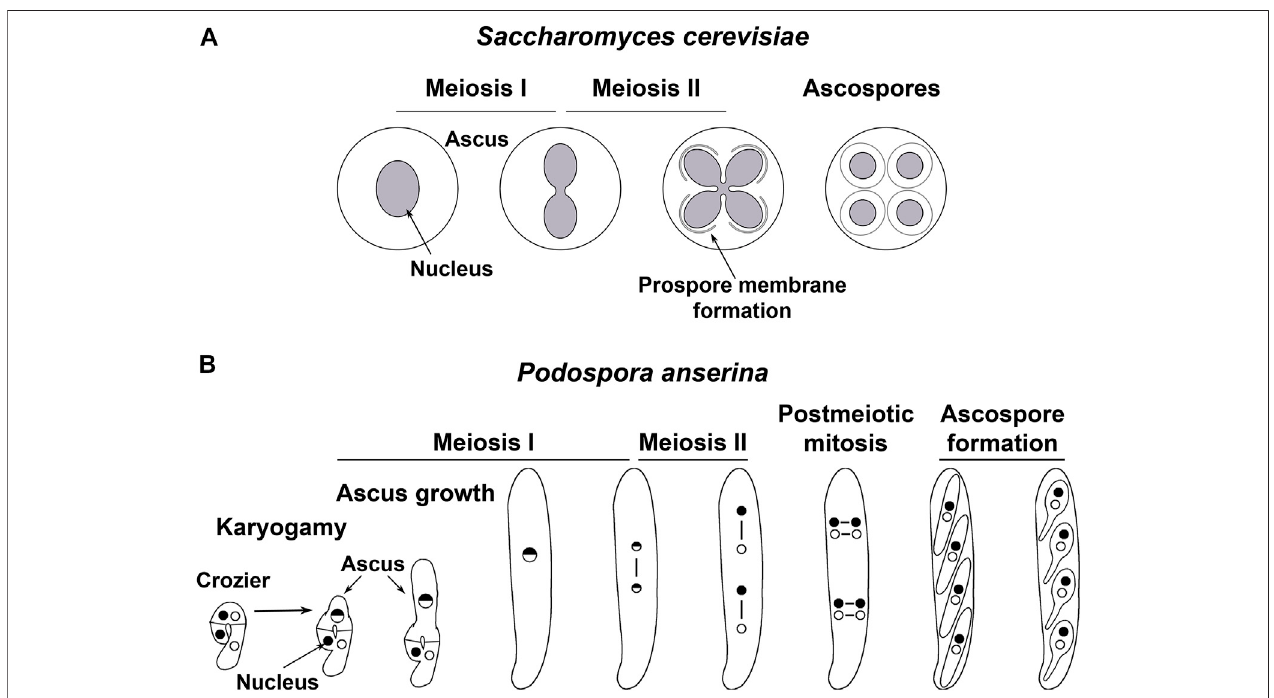
FIGURE 1 | Meiotic development in two model fungi. (A) In the budding yeast Saccharomyces cerevisiae , diploid cells produced after mating undergo meiosis when exposed to nutritional limitations. During this process, the NE remains continuous along both meiotic divisions. By meiosis II, new membranes are produced from the NE-embedded SPBs (not depicted) of each lobe of the dividing nucleus – termed prospore membranes – , which expand encircling each nucleus and a fraction of cytoplasmic contents. Meiotic spores (ascospores) are delineated upon closure of the prospore membrane, which separates the ascospore cytoplasm from the cytoplasm of the original mother cell. Ultimately, proteases released after permeabilization of the mother cell vacuole degrade the cytoplasmic contents excluded from ascospores (Neiman, 2011; Eastwood et al., 2012; Eastwood and Meneghini, 2015). (B) . In the mycelial ascomycete Podospora anserina , sexual development takes place within multicellular fructi fi cations known as perithecia (not shown). Within these structures, nuclei from both parental origins (depicted as dots with different shading) are isolated in pairs in specialized cells termed croziers. The crozier dikaryotic cell undergoes karyogamy while enters meiosis and differentiates into an ascus (the meiocyte), which elongates along prophase I. After meiosis completion, the four resulting nuclei divide mitotically to yield eight nuclei, which are packaged by pairs into four ascospores (Zickler et al., 1995).